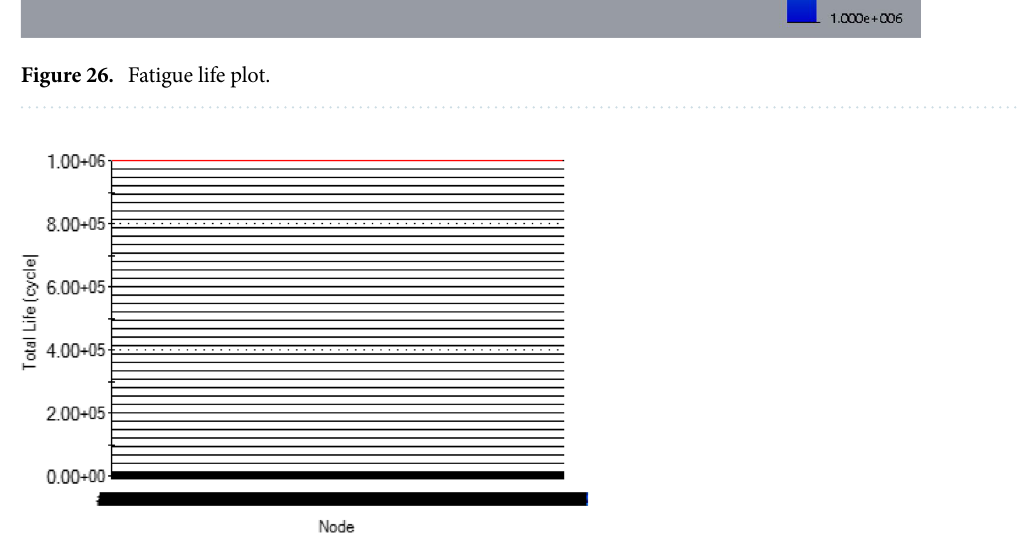
Figure 27. Simulation graph for fatigue